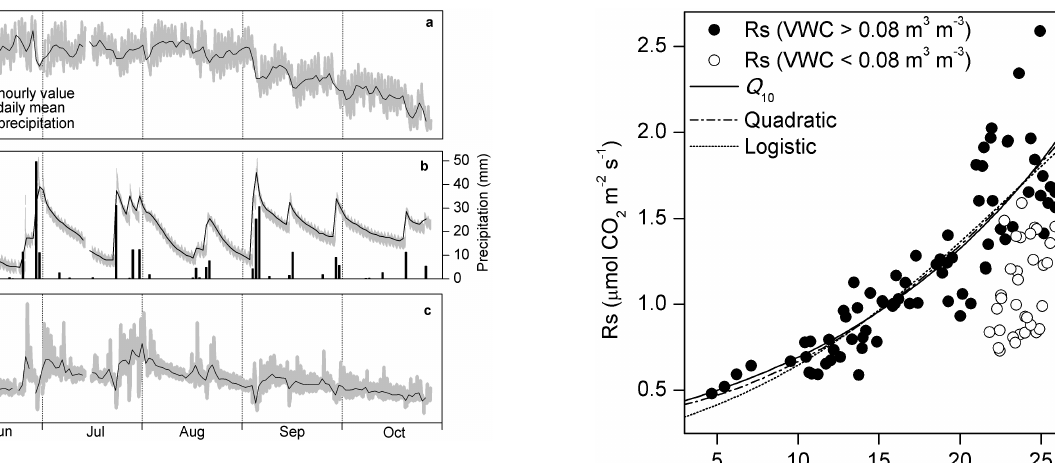
Fig. 5. Seasonal cycles of soil temperature (Ts), volumetric soil wa- ter content (VWC), precipitation, and soil respiration (Rs). Ts and VWC were measured at 10cm depth. Hourly values are plotted in light grey; the solid line is the daily mean. The precipitation bar plot shows the daily totals.